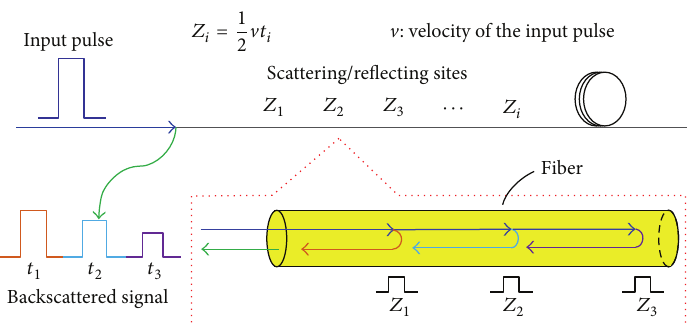
Figure 3: Measurement principal of OTDR